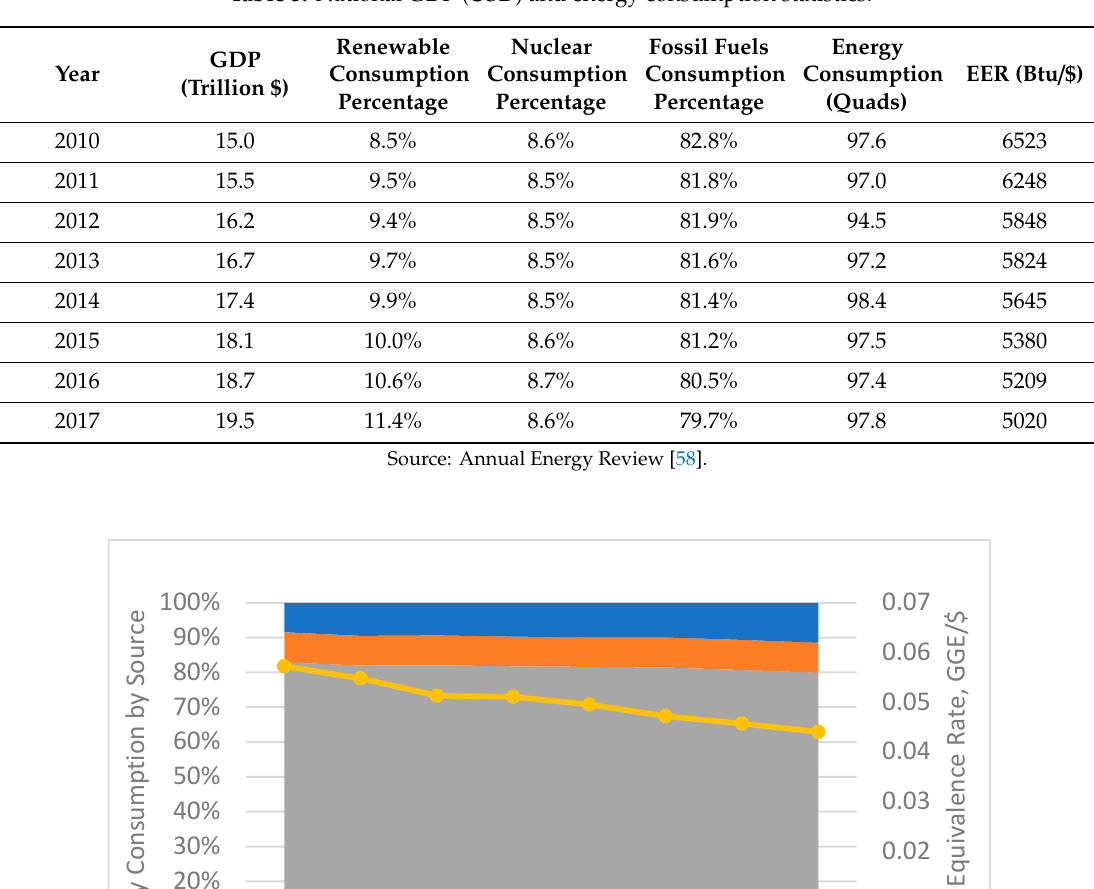
Figure 7. Total gasoline gallon equivalent (GGE) cost from 2010 to 2017. The EES per fatal and injury crashes were 246,360 and 5320 gallons, respectively. By contrast, the EES per PDO crash is only 508 gallons for the year 2010. The values of EES per crash for all crash types are illustrated in Table 6. The change of EES per crash for three crash types with regard to 2010 is displayed in Figure 8. The overall trend for EES per crash is declining, and it shares the same overall trend with the corresponding EER curve (shown in Figure 6). Compared to the economic factors such as CPI and MUWE, EER plays a more significant role in the value of EES. Table 6. Energy equivalence of safety (EES) per crash type. Category